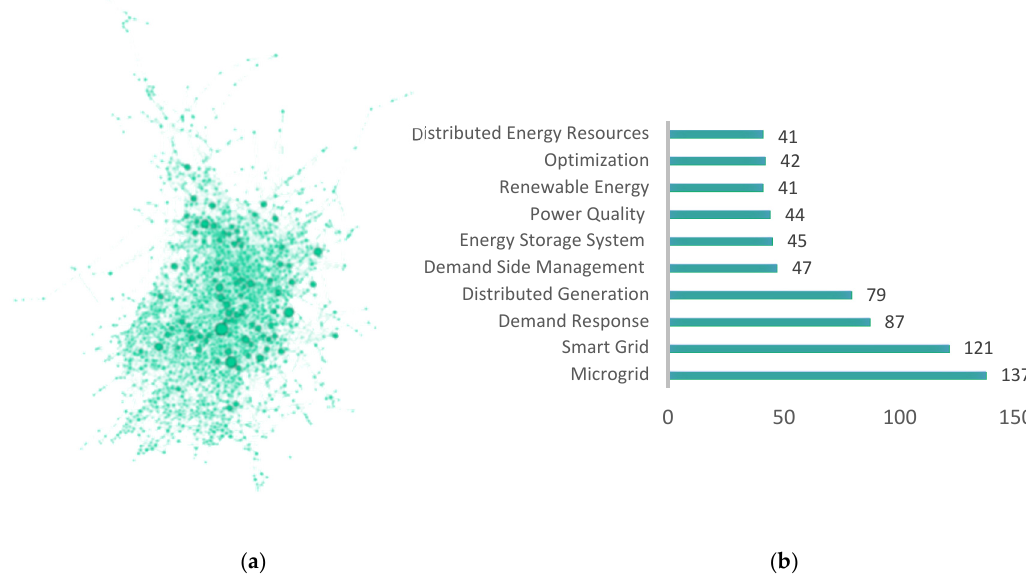
Figure 12. Smart grid: ( a ) manuscripts published, ( b ) keywords.